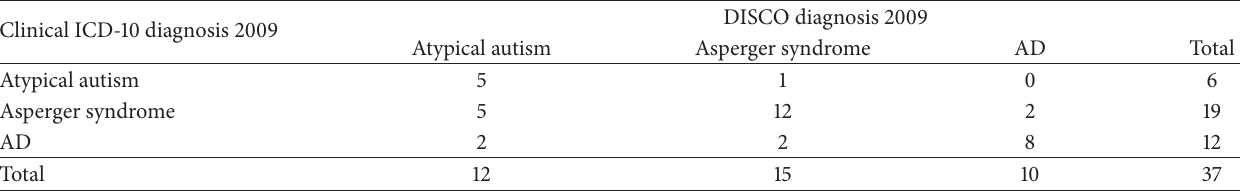
Table 3: Correspondence between clinical diagnosis and DISCO diagnosis at followup ( 𝑛 = 50 ). Clinical ICD-10 diagnosis